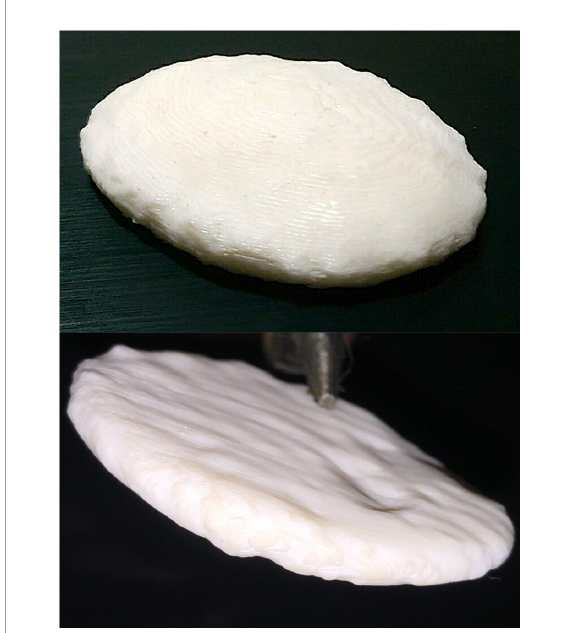
FIGURE12 Picture of the front and back of the three-dimensional (3D) printed heart scarab amulet inside the torso cavity of mummy TR 21/11/16 at (Cairo Egyptian Museum). The amulet is made of plastic and has a discoid shape with a convex surface (at the top of the picture) and a flat surface (at the bottom of the picture) with depression marks likely representing inscriptions.